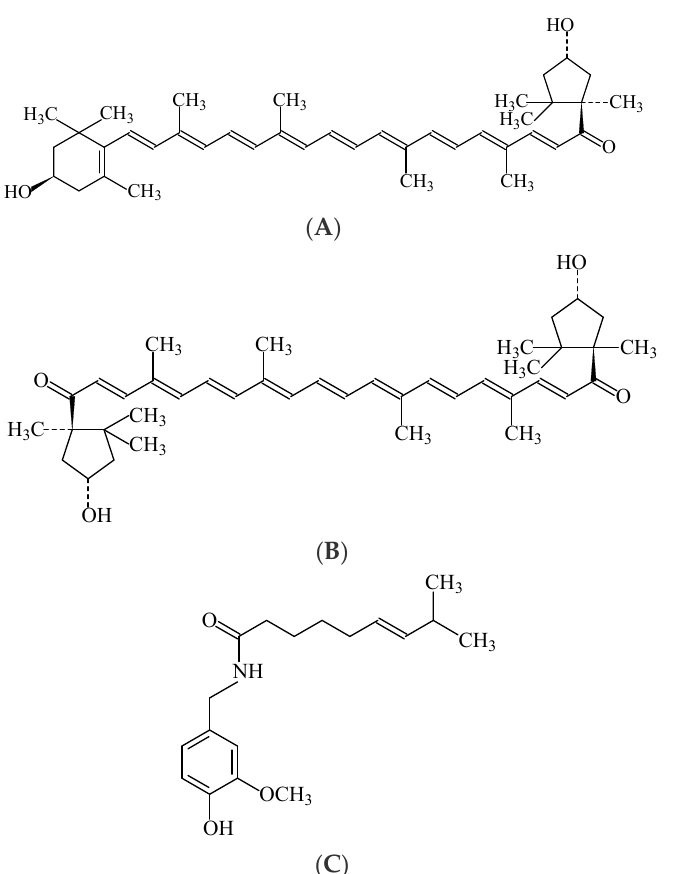
Figure 7. Structure formulae of capsantin ( A ), capsorubin ( B ) (colored components of pepper extract), and capsaicin ( C ), the main flavouring component of chili extract.